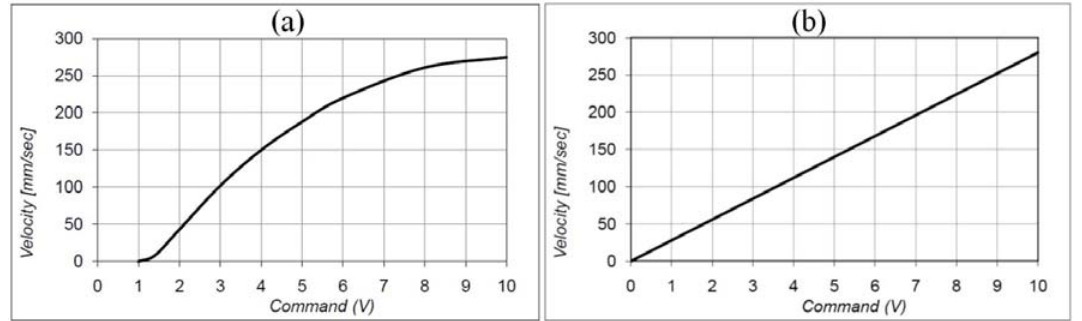
Figure 5. Linear stage maximum velocity as function of controller command voltage applied to the